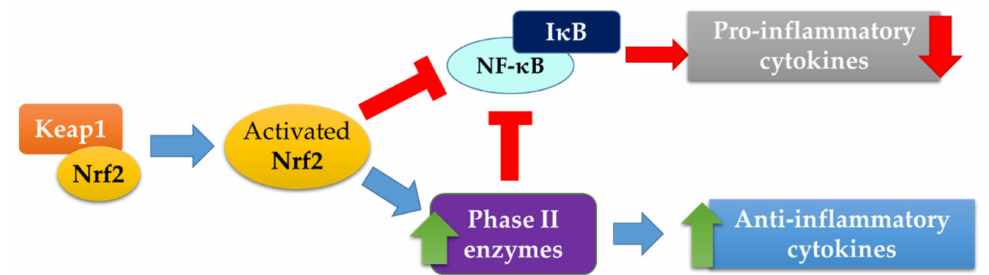
Figure 1. Schematic representation of the crosstalk between antioxidant and proinflammatory path- ways. Keap1: Kelch-like ECH-associated protein 1; Nrf2: nuclear factor erythroid 2-related factor 2; NF- κ B: nuclear factor kappa-light-chain-enhancer of activated B cells; I κ B: inhibitor of nuclear factor kappa